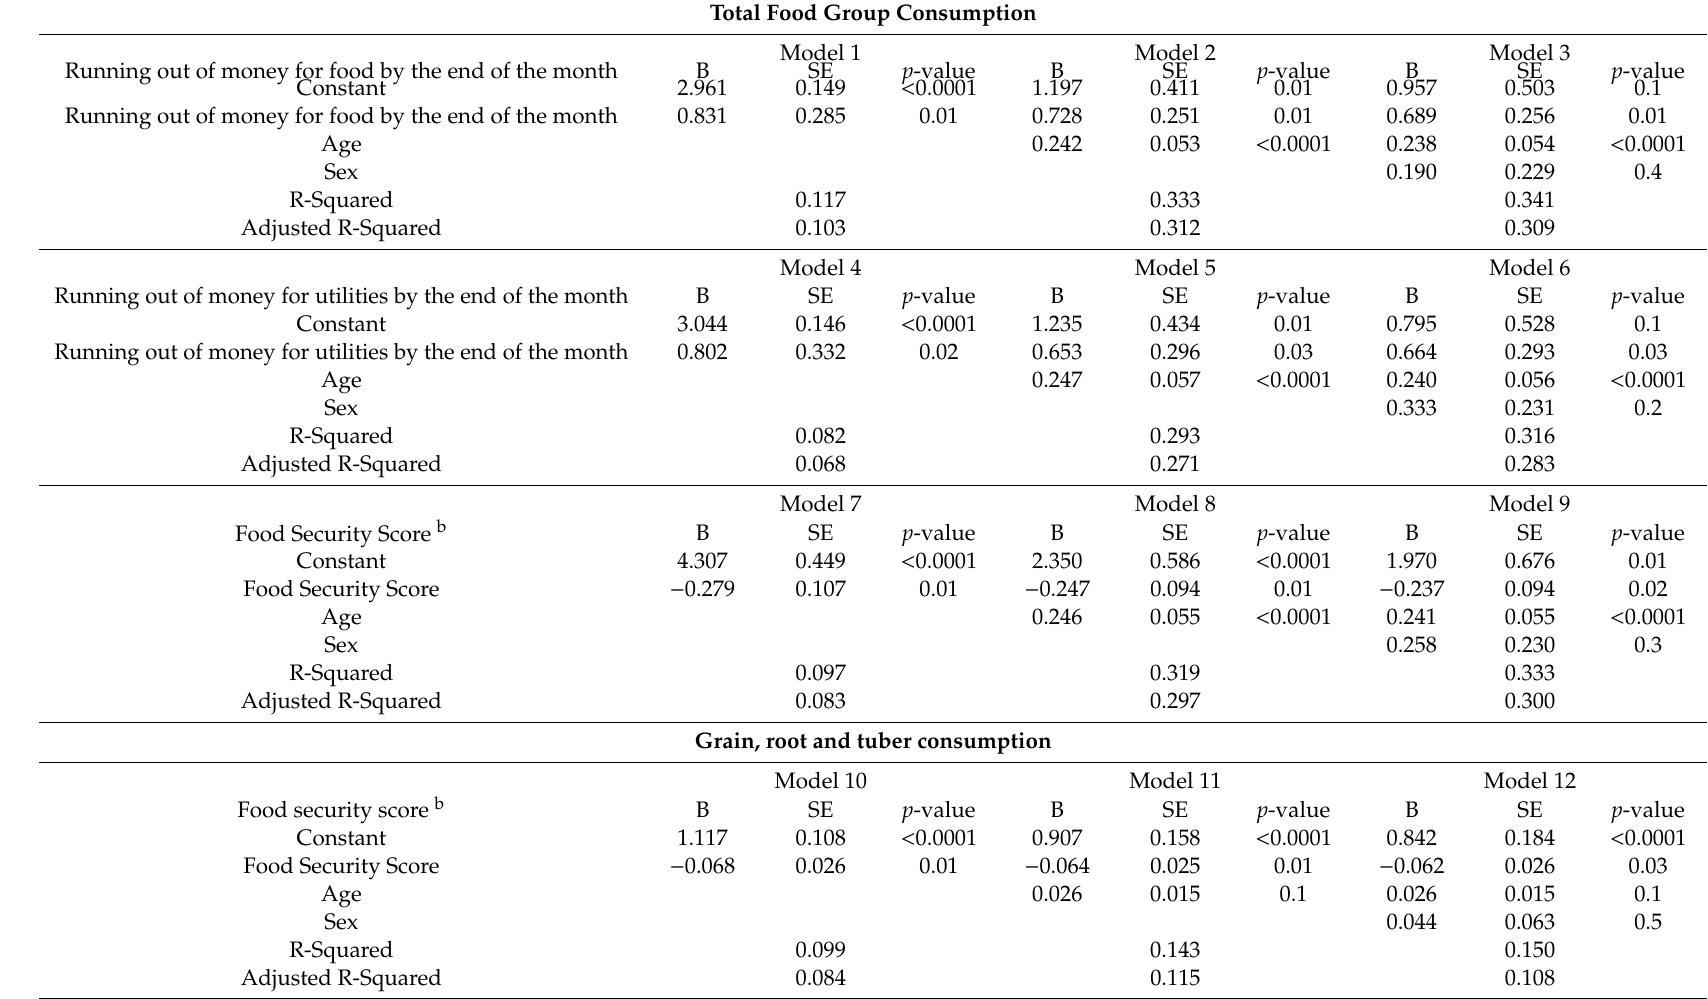
Table 7. The association between infant food security indicators and total and individual food group consumption in infants 3–12 months examined using linear regression ( n = 70) a